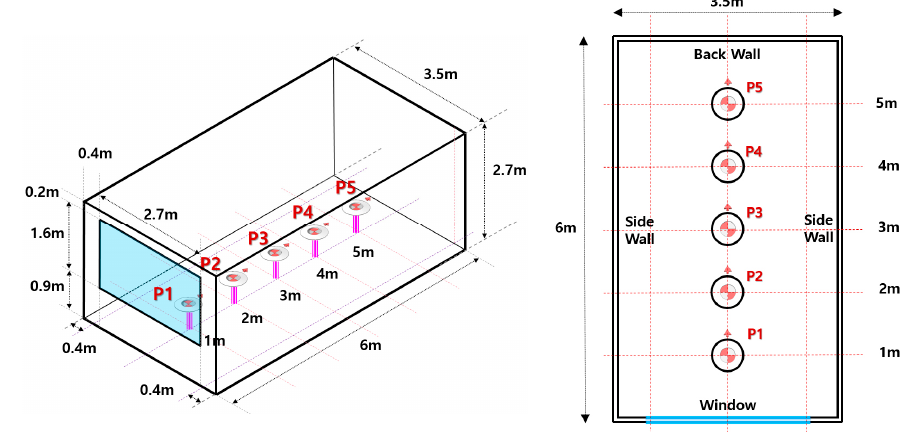
Figure 6. Simulation model and illuminance sensors installation.